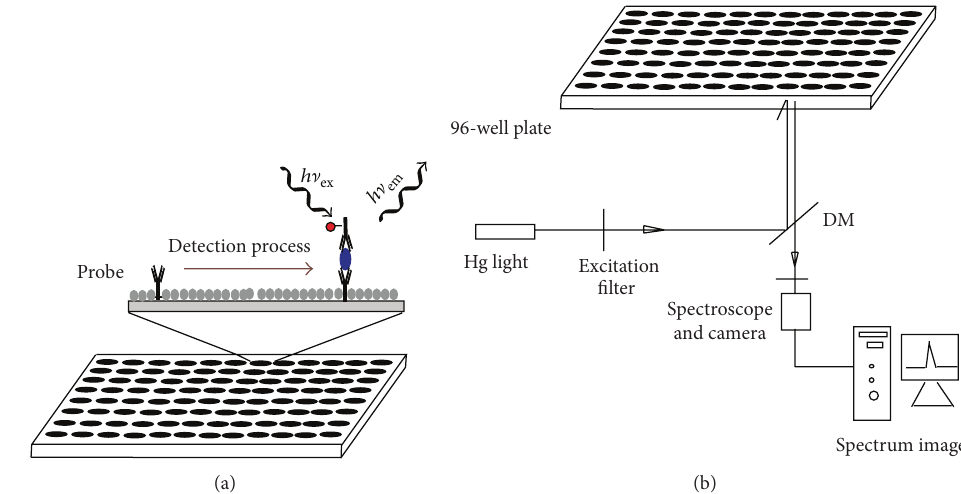
Figure 1: Schematic illumination of antigen and antibody concurrent immunoassay based on the 96-well plate (a) and the fluorescent microscopy based experimental setup (b).